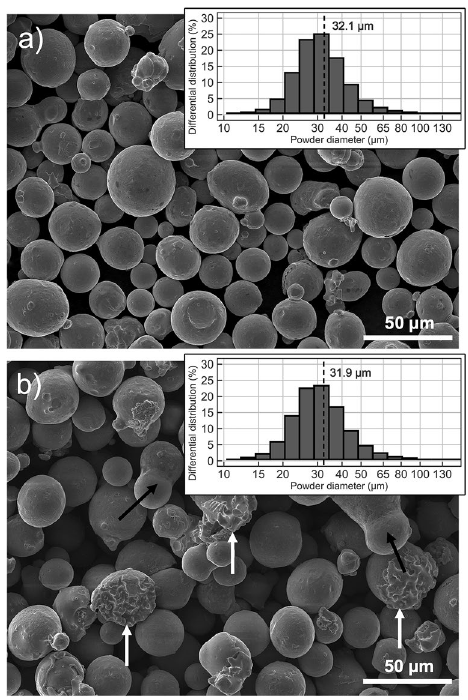
Figure 1. SEM images and particle size distribution of the CoCr virgin ( a ) and reused ( b ) powder.